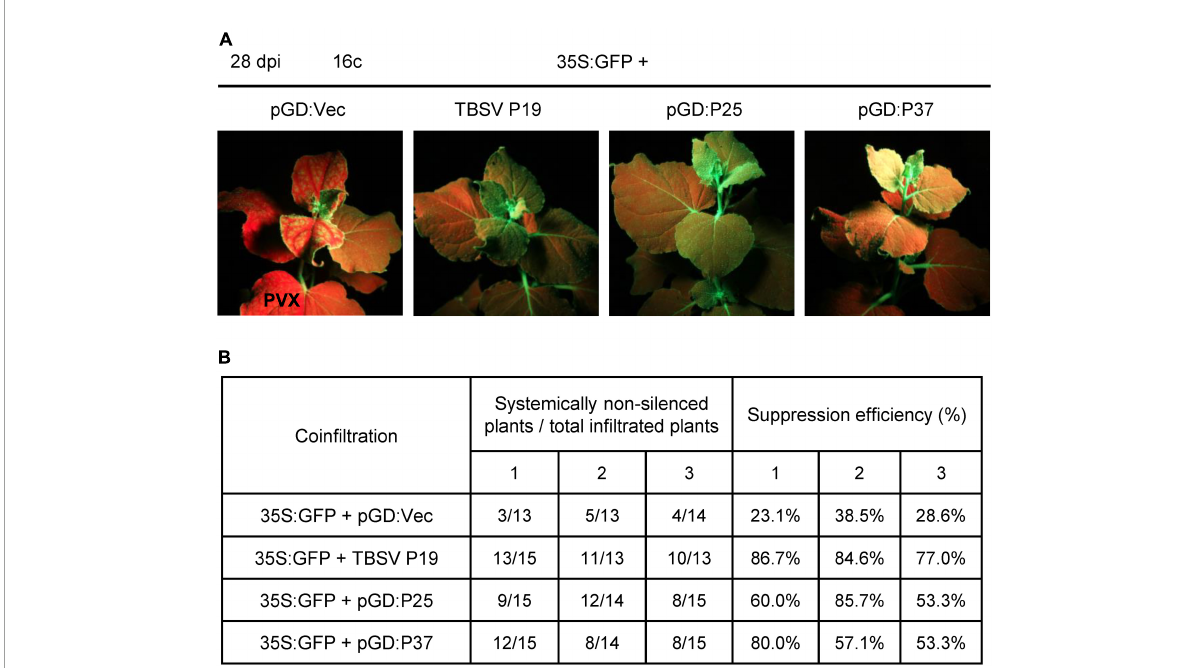
FIGURE4 Firespike leafroll-associated virus (FLRaV) P25 and P37 can inhibit the post-transcriptional gene silencing (PTGS) of systemic green fluorescent protein (GFP) in 16c Nicotiana benthamiana . (A) 16c N. benthamiana seedlings were co-infiltrated with Agrobacterium tumefaciens containing the binary vector expressing GFP (35S:GFP) plus pGD:Vec, TBSV P19, pGD:P25, or pGD:P37 at 28 days post infiltration (dpi). Leaves of 16c N. benthamiana seedlings co-infiltrated with A. tumefaciens containing the 35S:GFP plus pGD:Vec or TBSV P19 were served as negative and positive controls, respectively. (B) Statistics of 16c N. benthamiana seedlings co-agroinfiltrated with the 35S:GFP plus pGD:Vec, TBSV P19, pGD:P25, or pGD:P37 showed systemic GFP RNA silencing at 28 dpi. At least 13 N. benthamiana seedlings were utilized in each independent systemic silencing